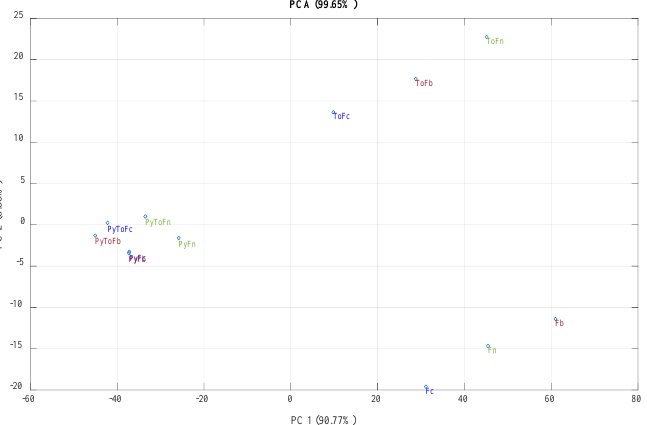
Figure 5. The PCA plot of needles, cones and bark from fir according to the chemical/compositional analysis and calorific values. A thermal analysis of the fir samples and of their solid residues from the torrefaction and/or pyrolysis was performed to obtain information on the degradation steps that are related with the composition of solid materials. The results are presented in Figure 6.